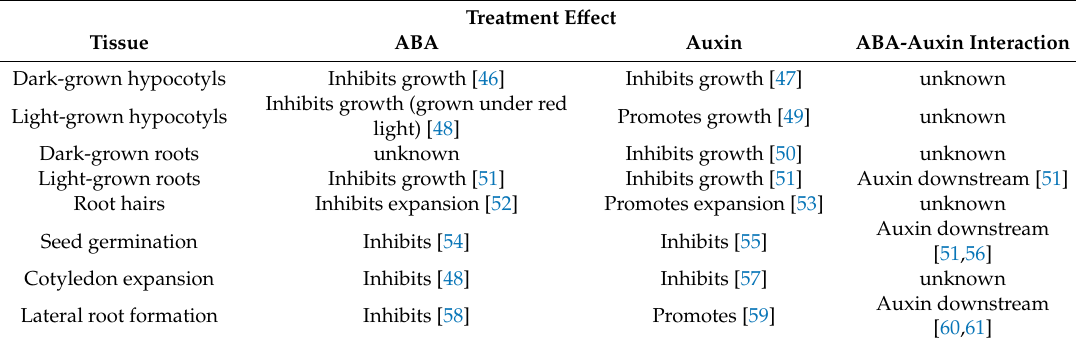
Table 1. E ff ects of exogenous auxin and ABA on various growth processes and their known